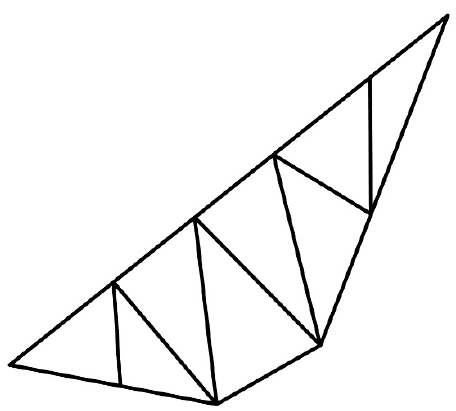
Figure 5. Adjustment of nodes (triangles vertices) for equidistance without “shorter sides” (The edge surrounded by the red circle in Figure 4).